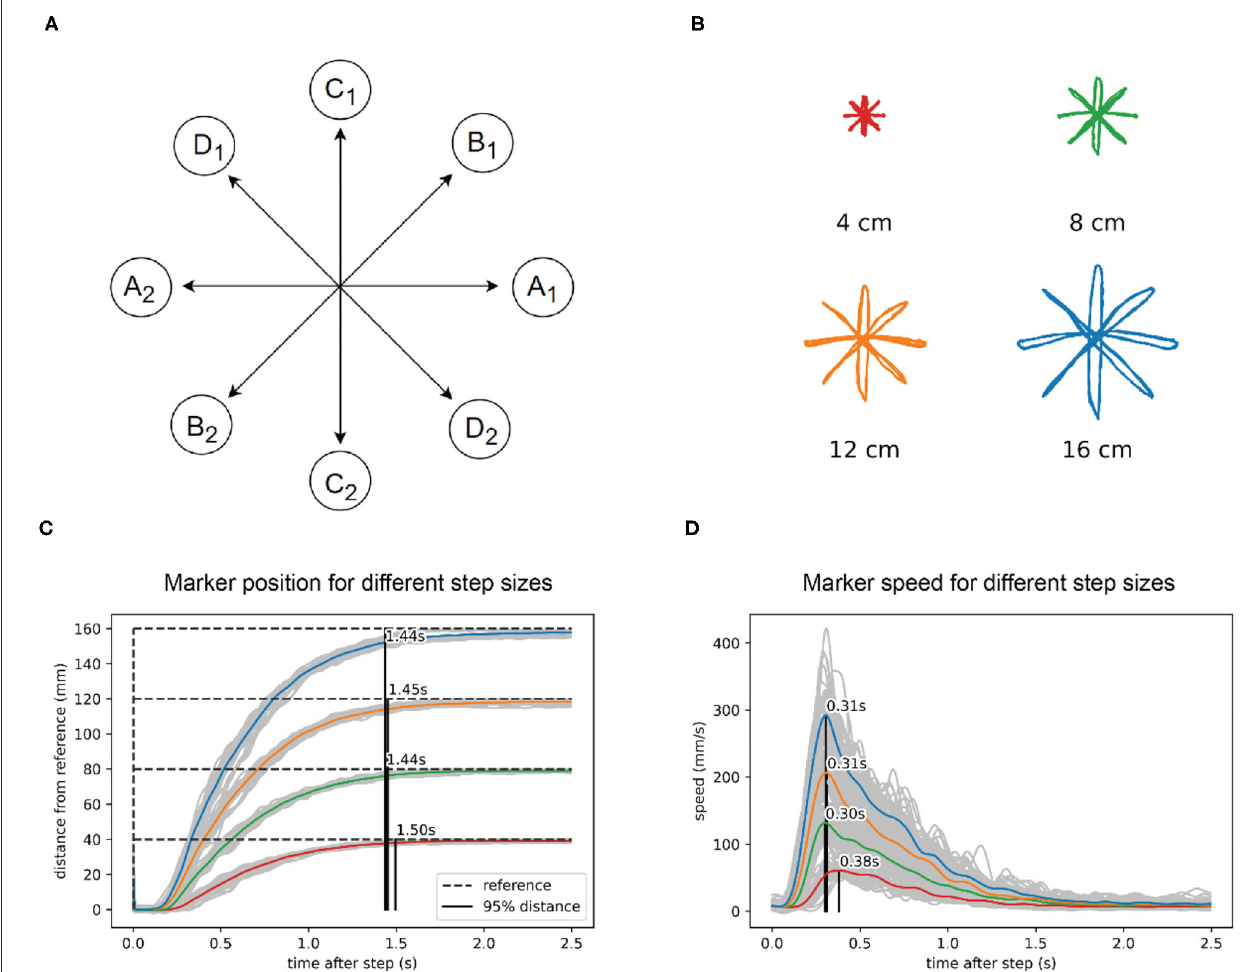
FIGURE 3 | In reaching to a visual reference, the robot arm shows isochrony and bell-shaped speed profiles. (A) Task diagram. The reference jumps between points A1 and A2, with a pause of 5s at each point. Then repeats the same pattern at points B1 and B2, C1 and C2, and D1 and D2. (B) Marker position data for four different sizes of the reference step. (C) Marker position in visual space calculated as the distance from the previous marker position. The marker reaches 95% of the distance to the reference after a step in about 1.45s, regardless of the distance or direction traveled. (D) Speed calculated from the same data shows a bell-shaped profile, scaled in height to step distance. The position data in plots B and C and was low-pass filtered with a 2nd order Butterworth filter with a cutoff at 15Hz, while the speed data filter had a cutoff at 5Hz.